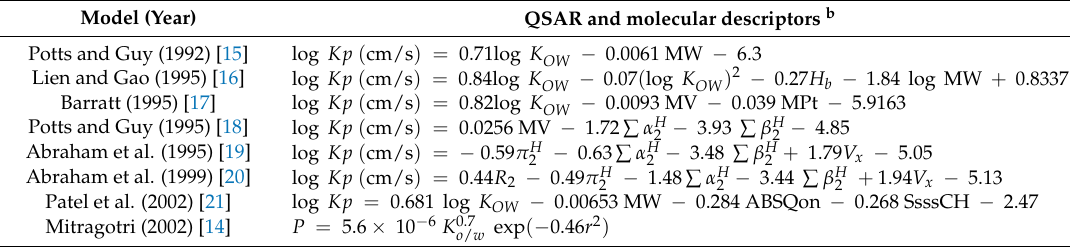
Table 1. Evolutionofquantitativestructure-activityrelationshipdevelopedforpredictingskinpermeability a . Model (Year) QSAR and molecular descriptors